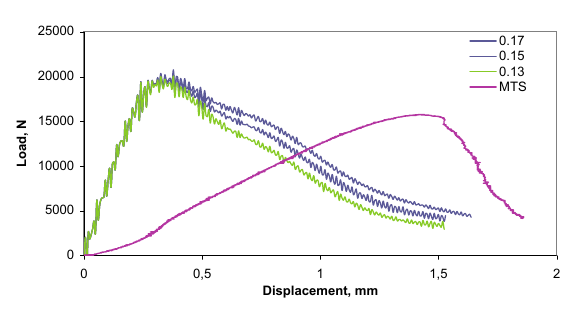
Figure 12: The load-crack extension values at the different maximum strength of the cohesive element and the comparison with the